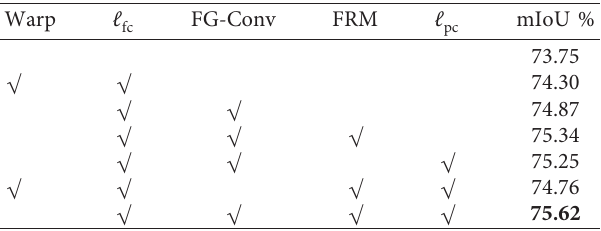
Table 1: Ablation study of our DWNet on the Cityscapes validation